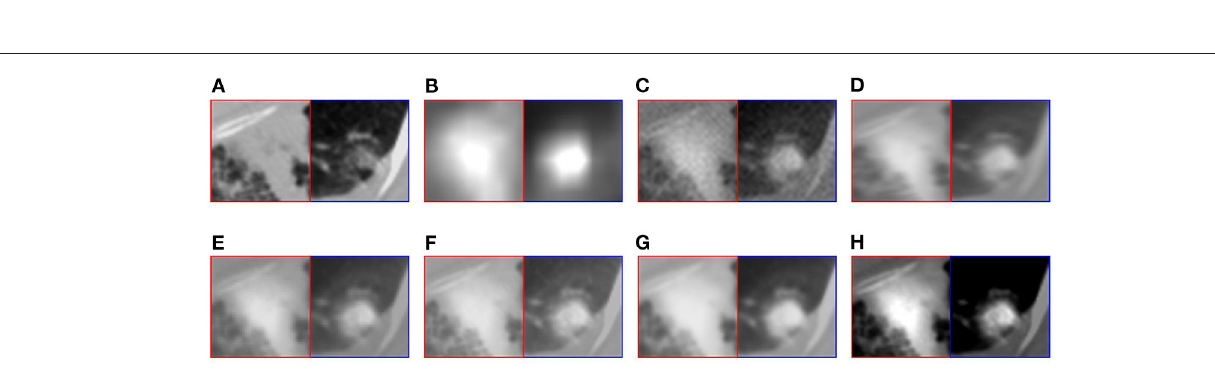
Frontiers in Medicine |